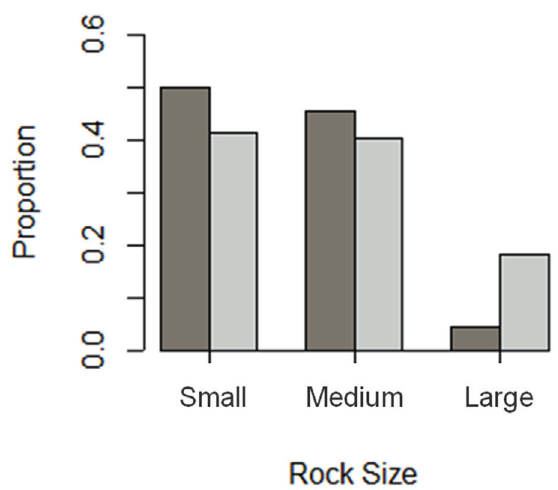
Figure 5. Histogram of proportions of Available versus Used basking sites according to the type of rock (small, medium and